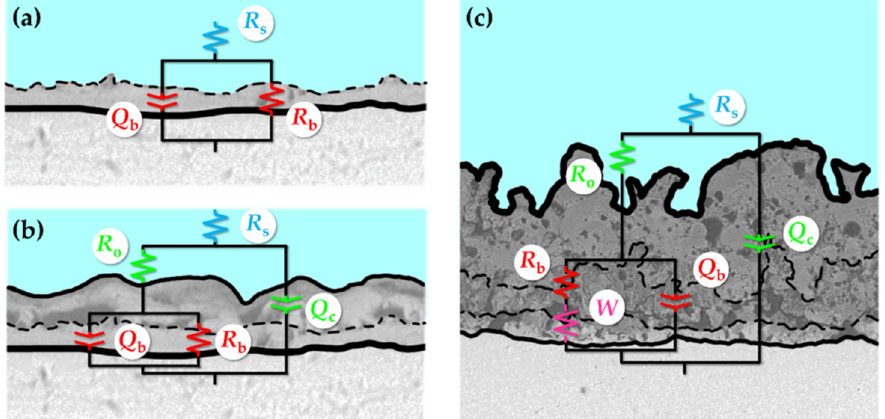
Figure 22. Equivalent electrical circuits used for fitting the impedance spectra of ( a ) the untreated Ta surface; ( b ) the MAO samples that showed two-time constants, and ( c ) those that exhibited two-time constants with a linear constant-phase region. Adapted from Ref. [64].